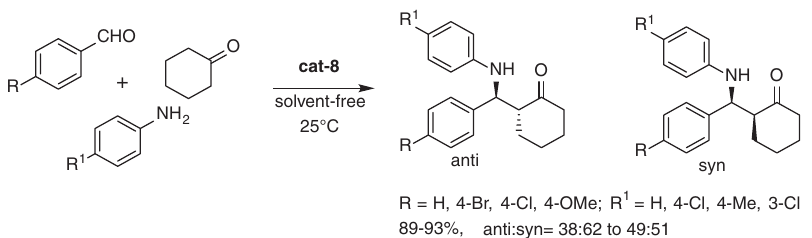
Scheme 17 Synthesis of β -amino carbonyl compounds promoted by cat-8.